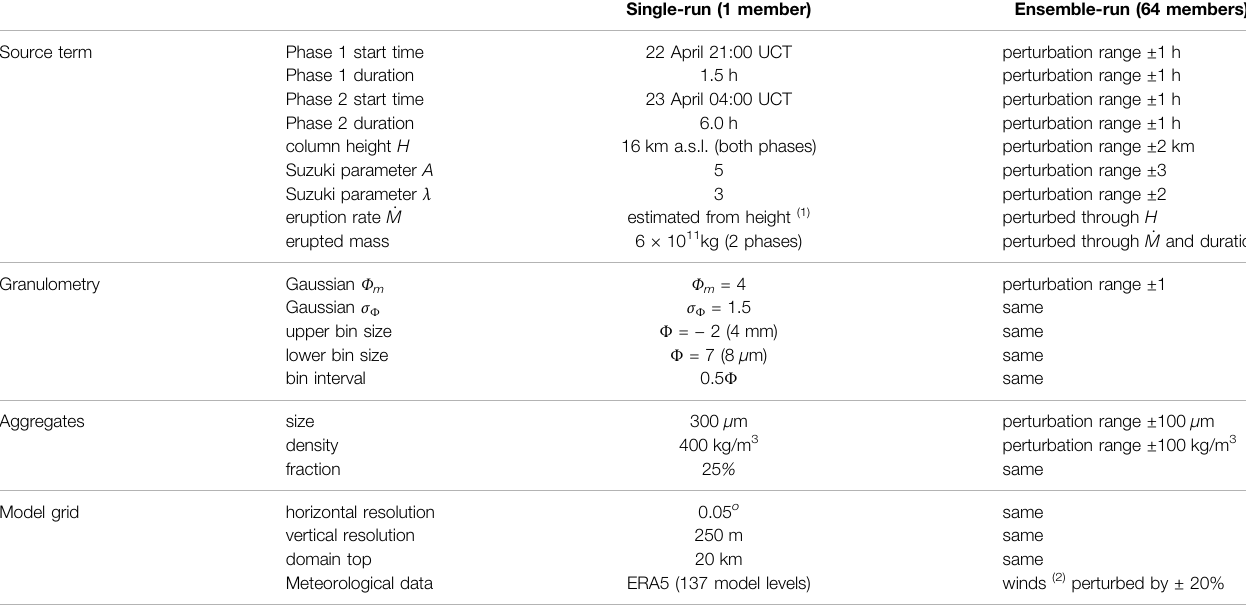
(1) Parameterisation as in Degruyter and Bonadonna (2012). (2) Horizontal wind components are perturbed globally (same perturbation in all grid cells).